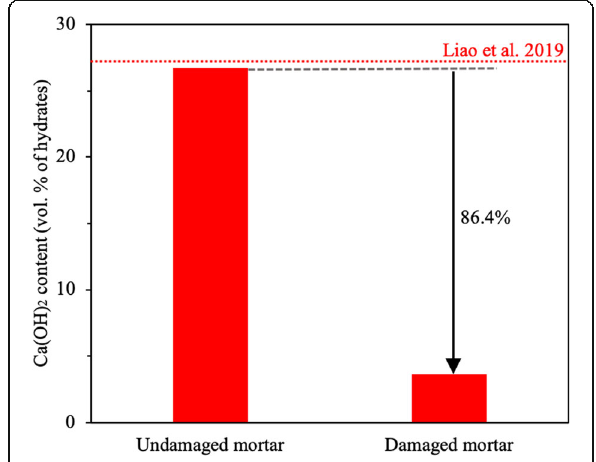
Fig. 10 Quantification of Ca(OH) 2 contents in the mortars using image analysis. The red dotted line indicates the value from Ref.